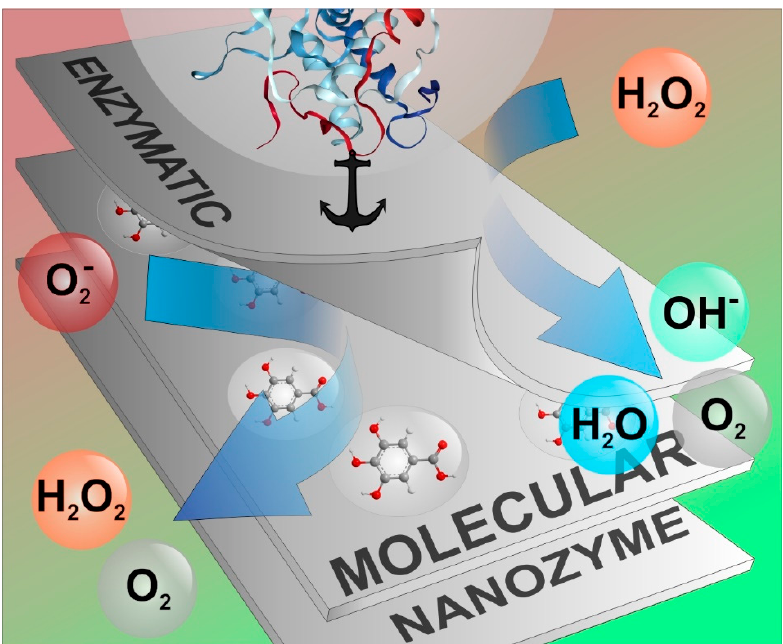
Figure 1. Illustration of molecular and enzymatic antioxidants immobilized in/on layered 2D materials. Schematic representation of superoxide radical anions and H 2 O 2 is also presented.